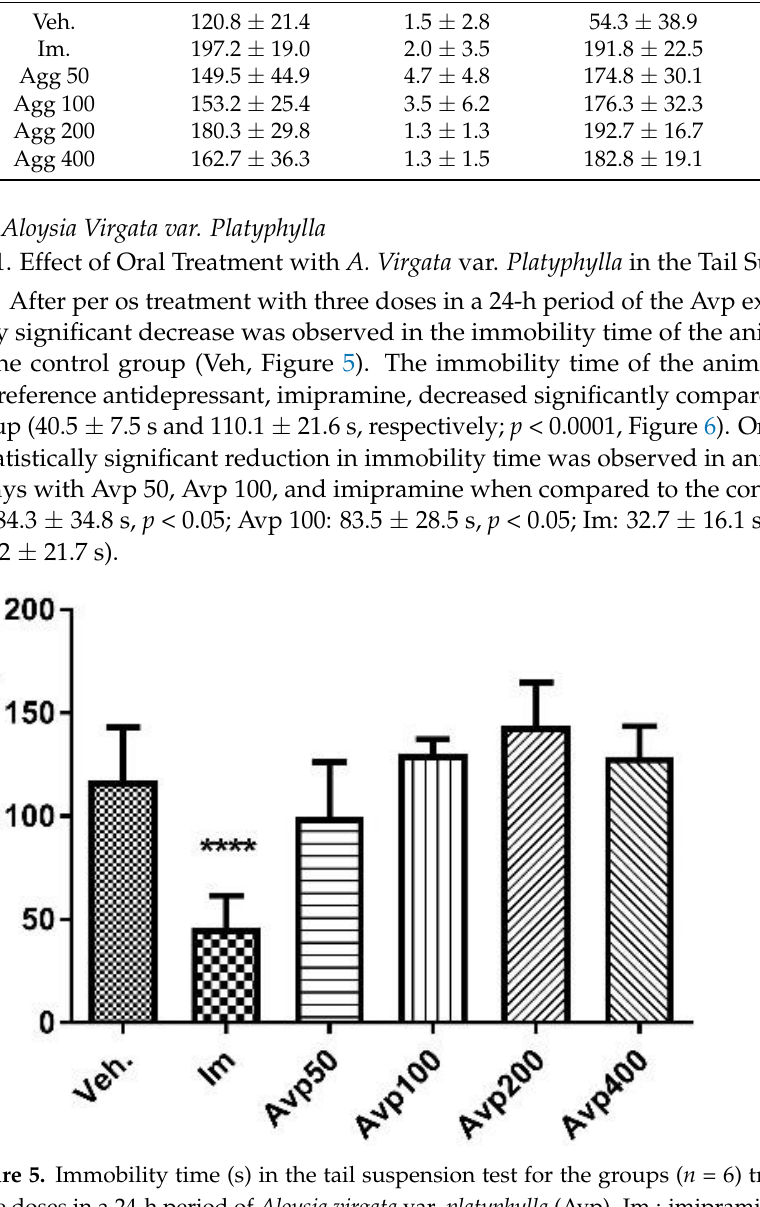
Table 1. Climbing and swimming behavior time of mice ( n = 6) after treatment with three doses in a 24-h period of Aloysia gratissima var . gratissima . Three Doses in 24 h 7 Days of Treatment Treatment Swimming (s) Climbing (s) Swimming (s) Climbing (s) Veh. 120.8 ± 21.4